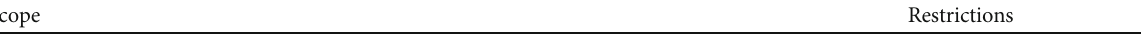
Table 1: Scope of search and restrictions.